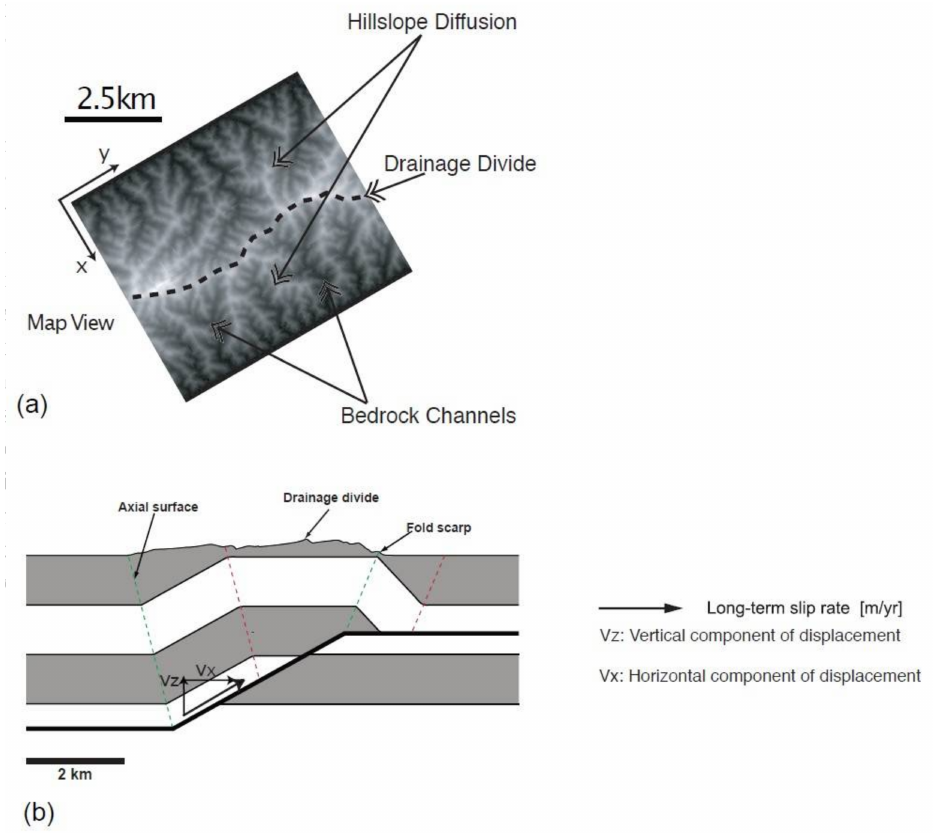
Figure 2. ( a ) Surface processes and ( b ) example structural template included in the numerical modelling approach. Two key surface processes are considered: bedrock channel development and diffusive erosion, transport and deposition. Tectonic deformation (fault-bend or fault-propagation folding) is modelled using kink-band kinematics where both active an inactive axial surfaces are present. See text for